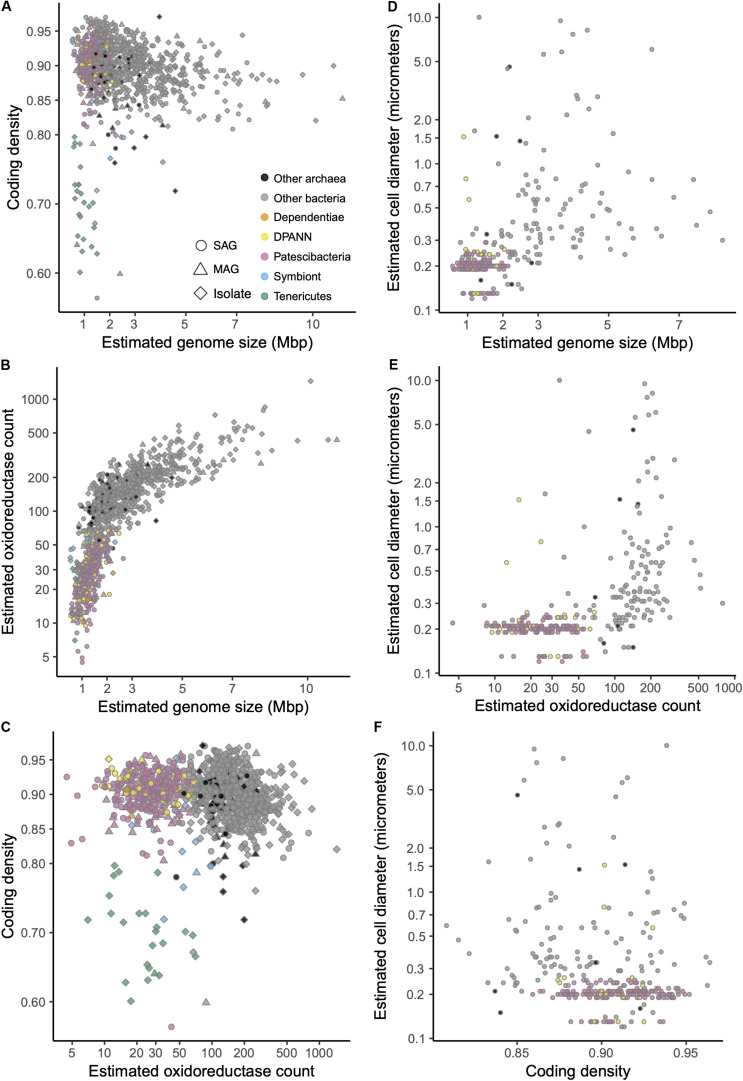
(A–F) Relationships between estimated genome size, coding density, oxidoreductase count, and cell diameter among SAGs (Supplementary Table S1) and other genome sequences (Supplementary Table S2) that were ≥30% complete and contained the 16S rRNA gene. Symbiont genomes are listed in Supplementary Table S4.